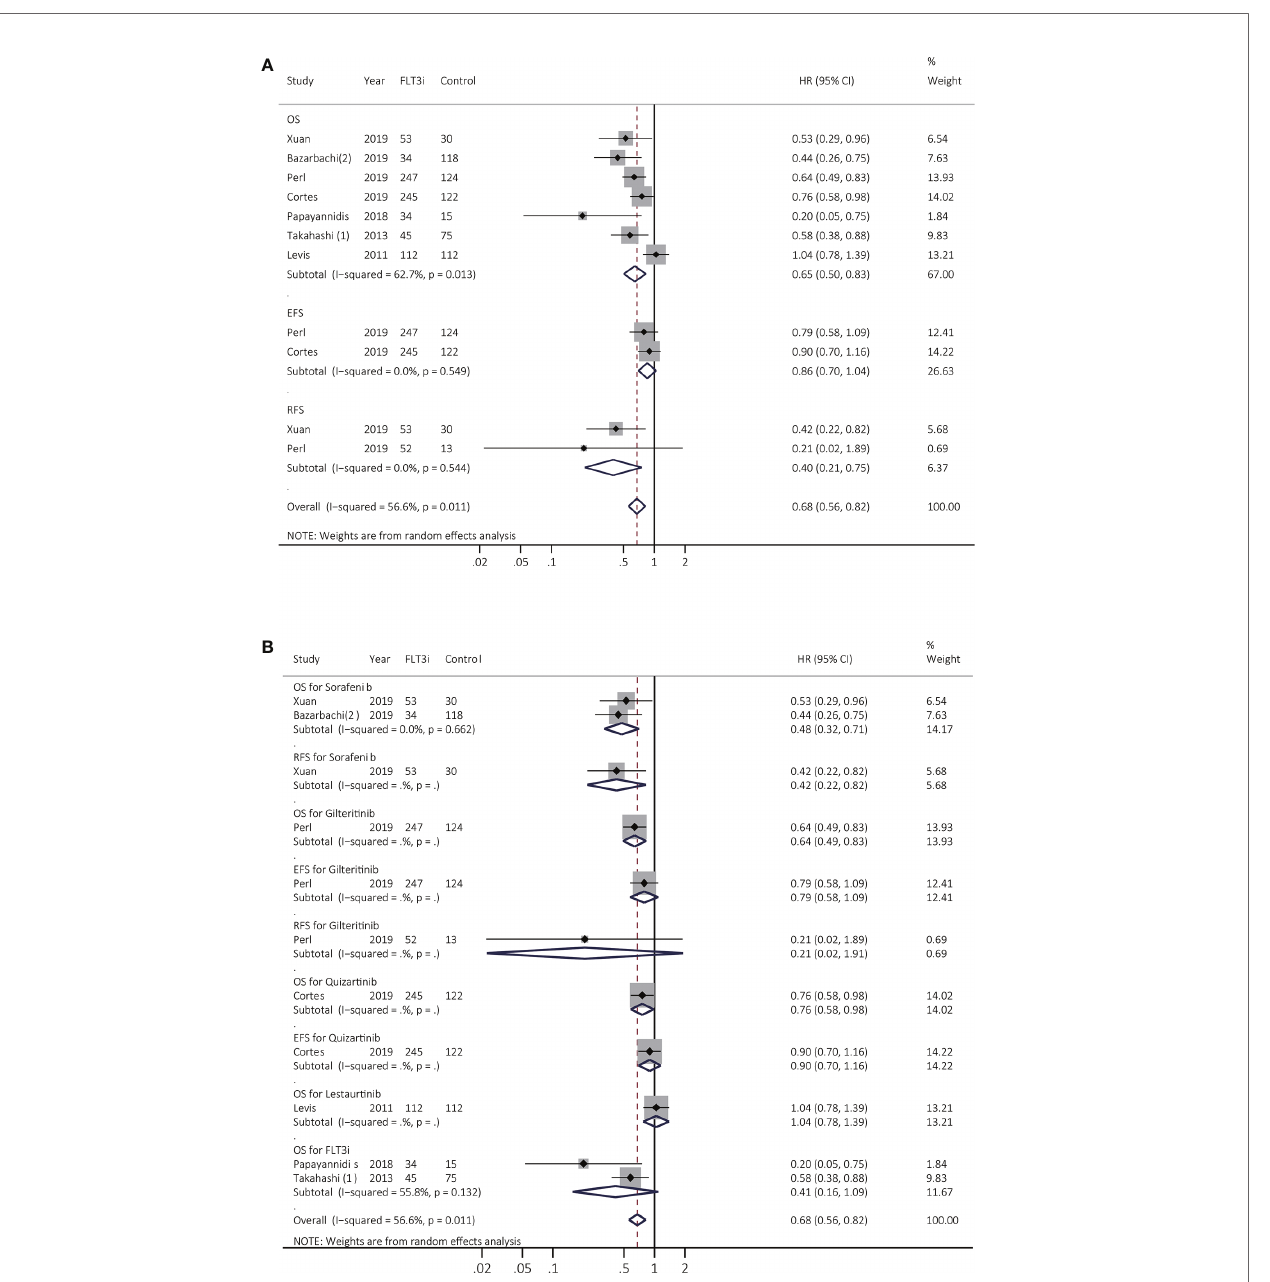
FIGURE 4 | Survival in fl uences of FLT3i on FLT3(+) rrAML. (A) Pooled HR and 95% CI of all FLT3i during salvage therapy in FLT3(+) rrAML for OS, EFS, and RFS; (B) Pooled HR and 95% CI of each FLT3i during salvage therapy in FLT3(+) rrAML for OS, EFS, and RFS. FLT3, FMS-like tyrosine kinase 3; FLT3i, FLT3 inhibitor; AML, acute myeloid leukemia; rrAML, refractory and relapsed AML; OS, overall survival; EFS, event-free survival; RFS, relapse-free survival; HR, hazard ratio; 95% CI, 95% con fi dence